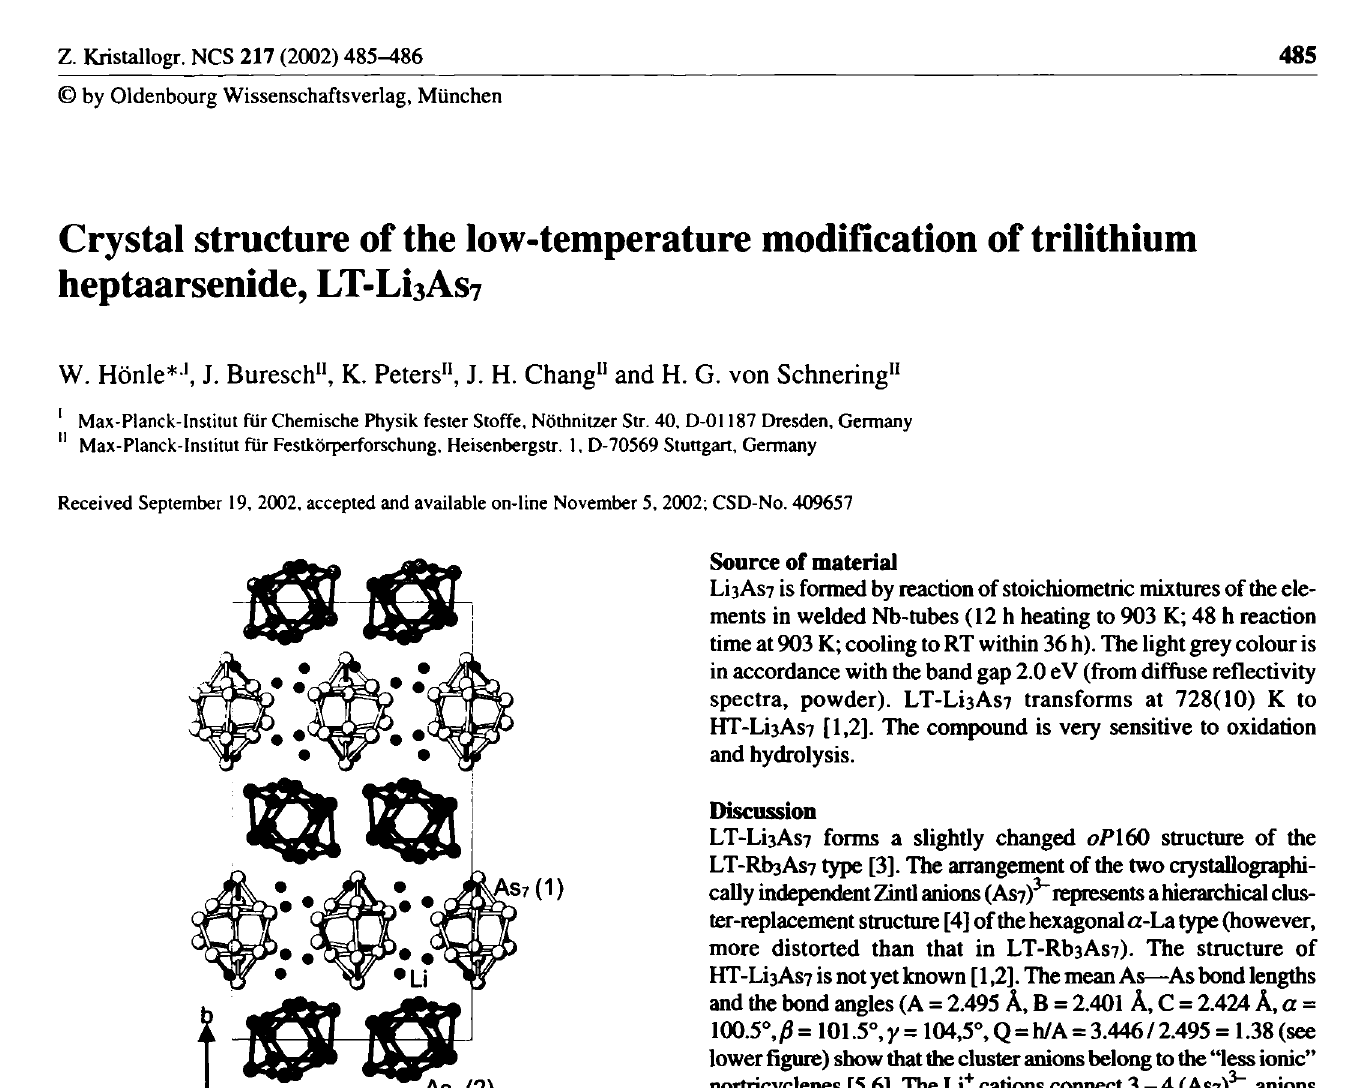
Table 1. Data collection and handling.